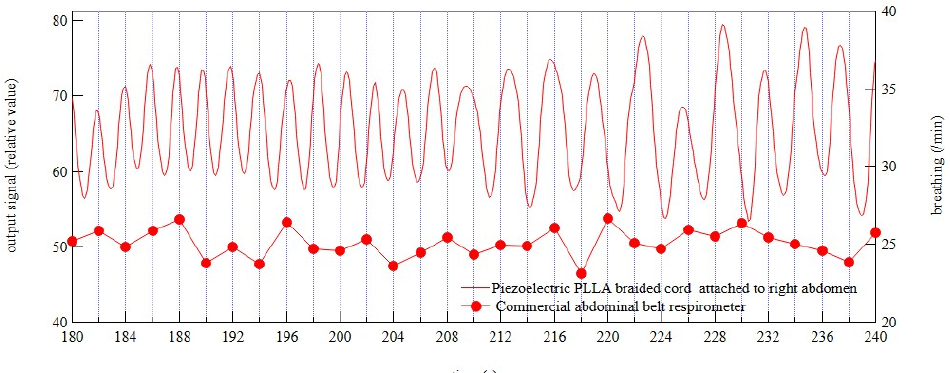
Figure 11. Response signal from a sensor embroidered on the right abdomen of the dog wear and respiratory rate from a commercial abdominal belt respirometer. The dog was measured while being held by its owner.